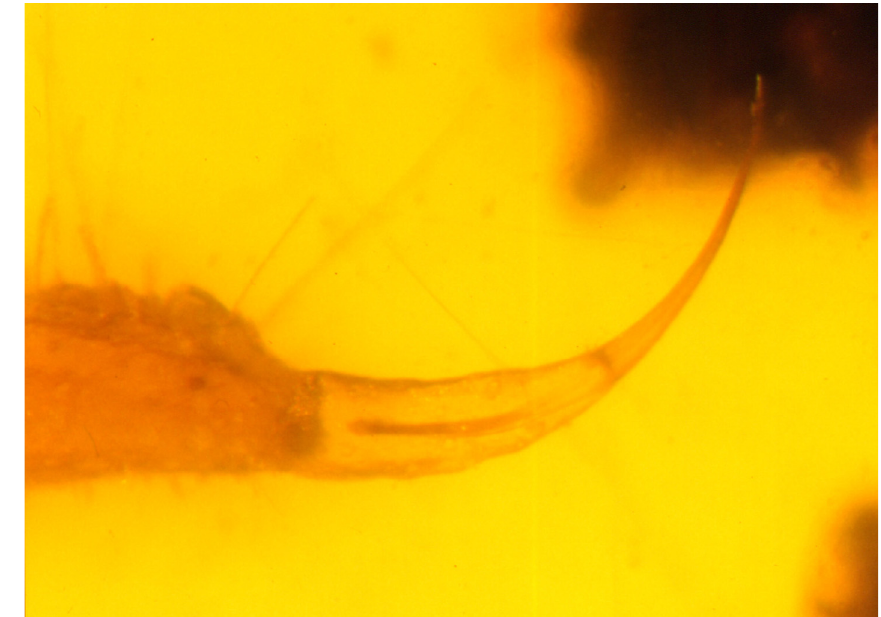
Figure 7. Slender telson with a long aculeus in the Cretaceous amber buthoid Palaeoburmesebuthus grimaldii Lourenço.